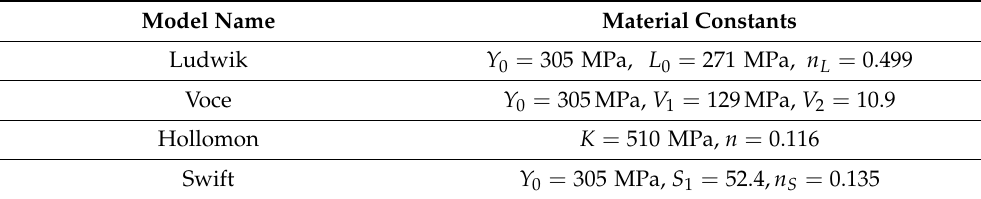
Figure 14. Comparison of flow stresses and their corresponding tensile test predictions of the four fundamental flow models with an emphasis on necking point and yield strength at zero strain. Table 2. Material constants of the four fundamental flow models focused on